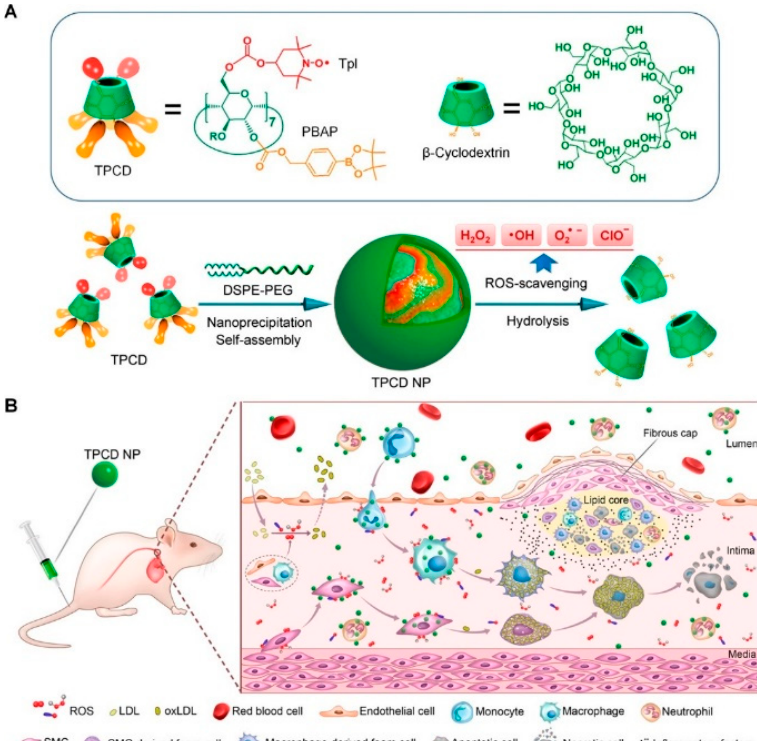
Figure 3. ( A ) Chemical structure and preparation of ROS-scavenging TPCD nanoparticles. ( B ) Schematic of targeted treatment of atherosclerosis in mouse model using TPCD nanoparticles. Adapted from [86].